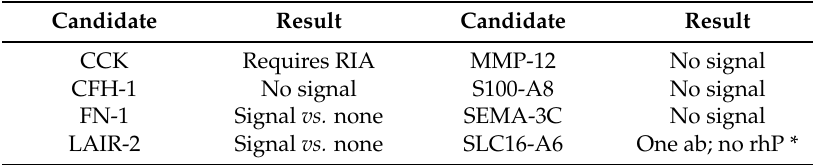
Table 6. Western immunoblotting results with monoclonal